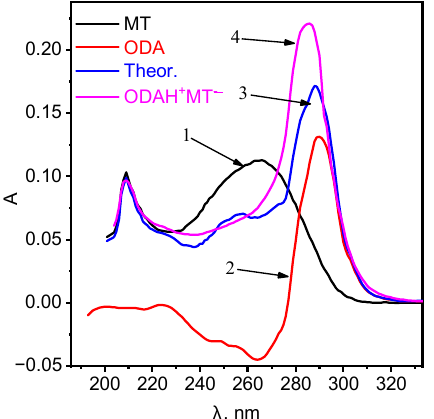
Figure 1. Absorption spectra of: 1—MT, 2—ODA, 3—summation of curves 1 and 2, 4—ionic associate ODAH + MT −